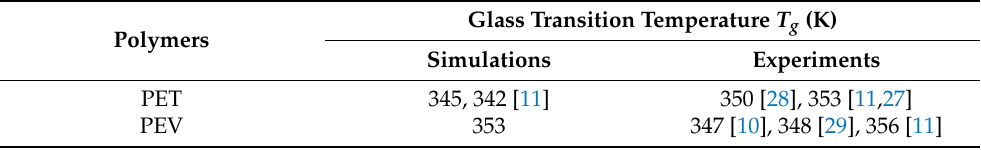
Figure 8. Temperature dependence of the specific volume for PET ( (cid:4) , solid line) and PEV ( • , dashed line). The intersection of the two trended lines defined the glass transition temperature ( T g ) of the polymer. Table 1. Glass transition temperature ( T g ) of PET and PEV predicted from our MD simulations compared to the previously reported theoretical and experimental data